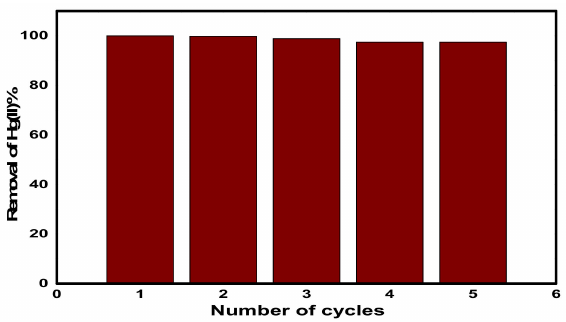
Figure 13. Hg(II) adsorption–desorption consecutive cycles on CuFe 2 O 4 @Polythiophene